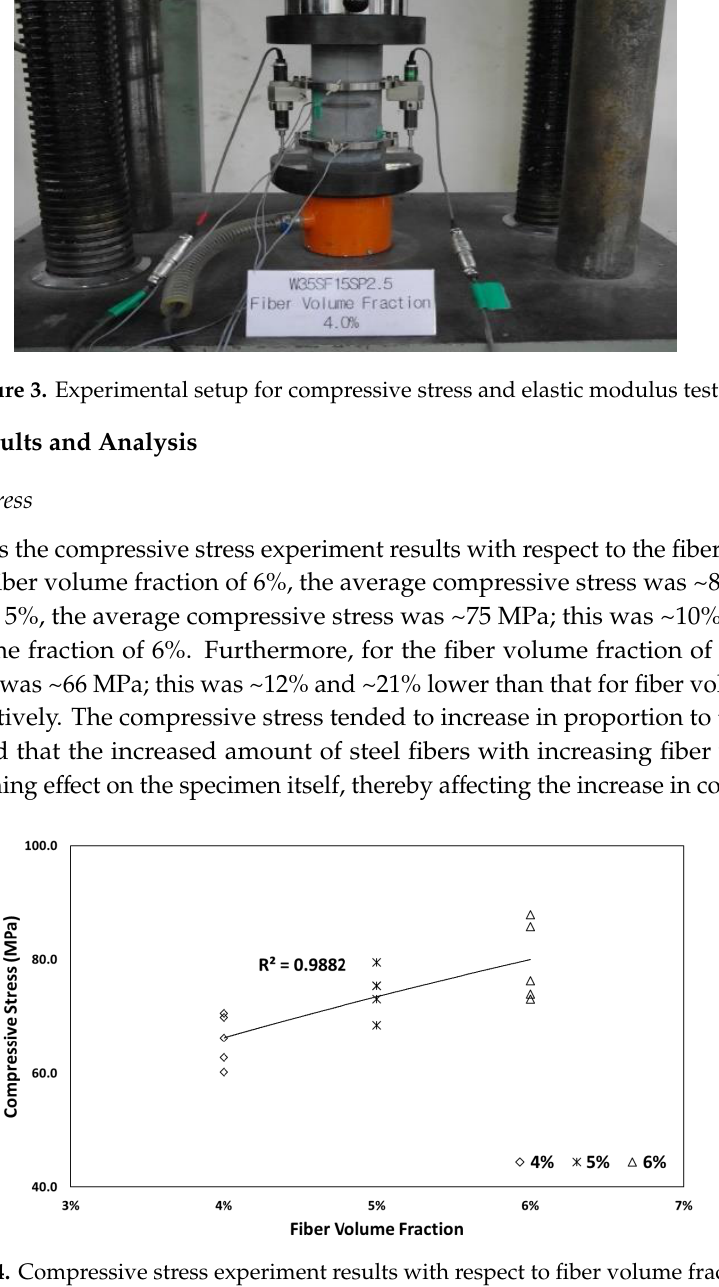
Figure 5. Strain at peak stress. Figure 6 shows the elastic modulus estimation curve using the compressive stress as presented in KCI 2012 [30] and ACI 318 [31] and the compressive stress and elastic modulus with respect to the fiber volume fraction. The elastic modulus with respect to the fiber volume fraction measured in this study satisfied the lower limit of the elastic modulus estimation curve. This seemed to be because the elastic modulus prediction equation suggested in KCI 2012 [30] and ACI 318 [31] estimated the elastic modulus using only the compressive stress and unit weight.